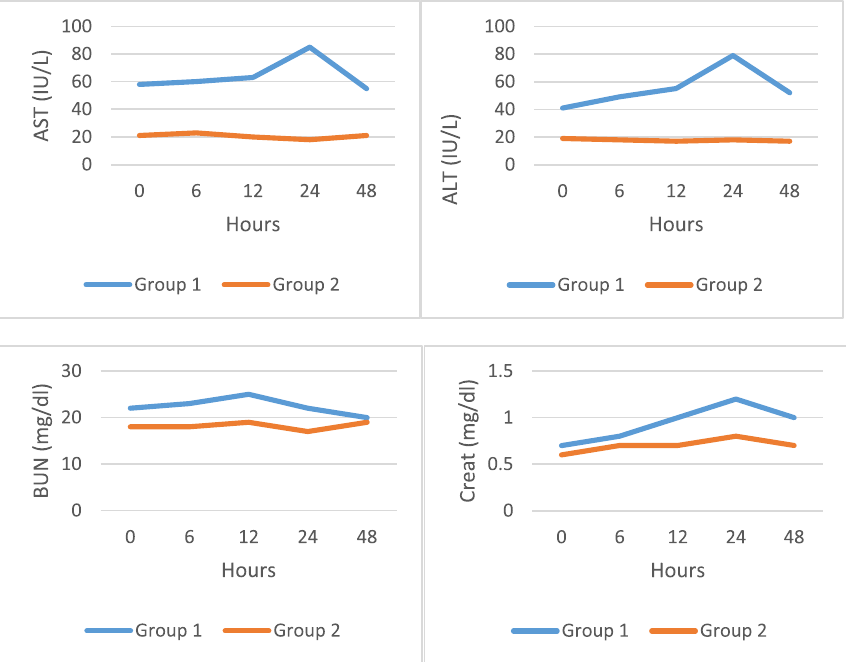
Fig. 2 Laboratory data for the 2 groups within 48 h of the closure. AST, aspartate transaminase; ALT, alanine transaminase; BUN, blood urea nitrogen